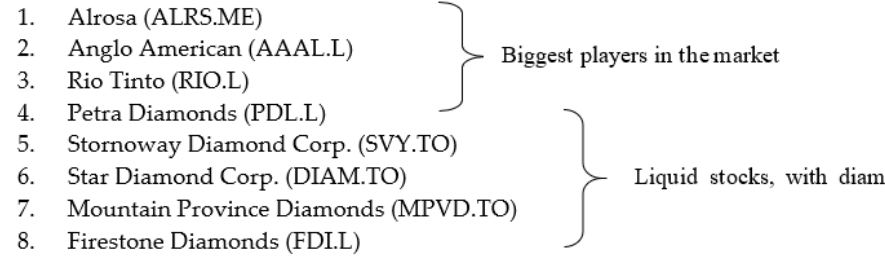
Table 1. Diamond-mining stocks traded at different exchange